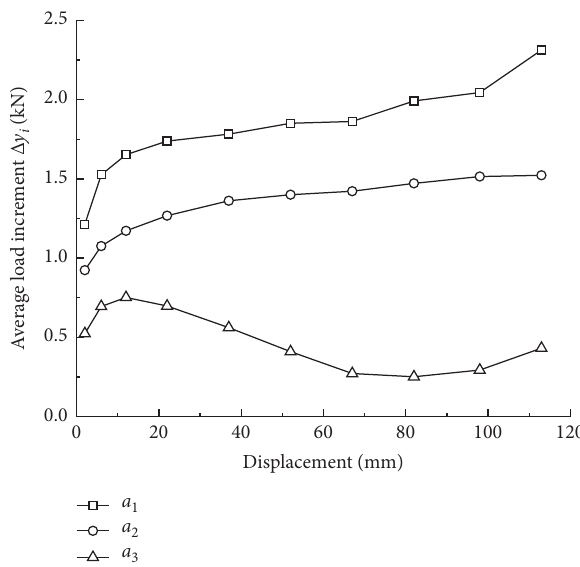
Figure 9: Influence of different materials on bearing capacity.